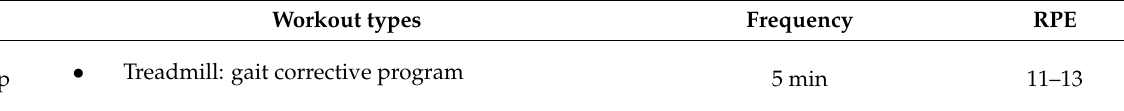
Table 2. Combined exercise